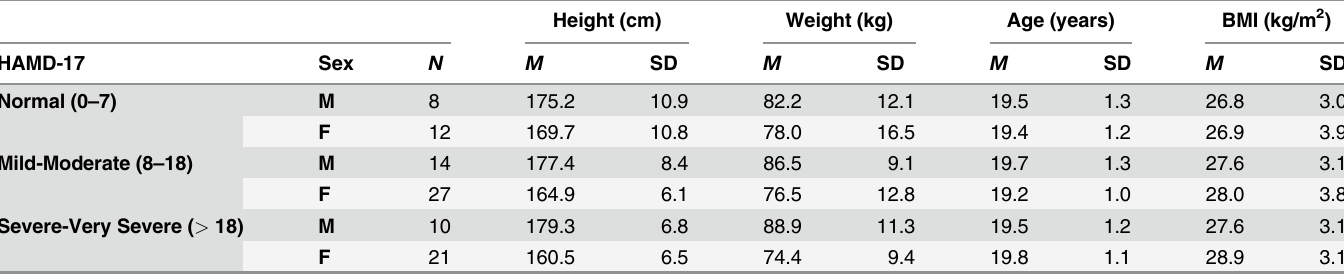
Table 1. Participant characteristics by sex and depression diagnosis